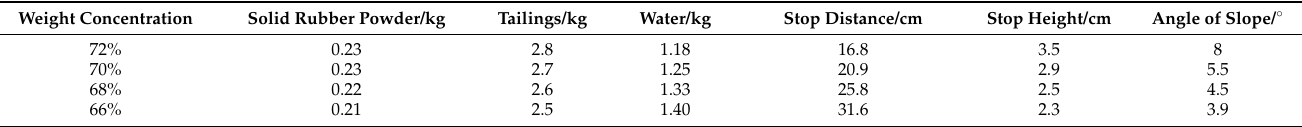
Figure 8. Effect of concentration on slope of tail mortar monolayer: ( a ) 72%; ( b ) 70%; ( c ) 68%; ( d ) 66%.